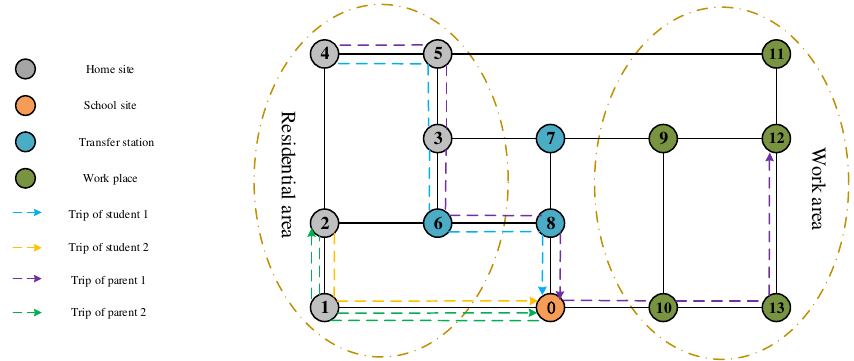
Figure 2. Network diagram of the private-car commuting model.